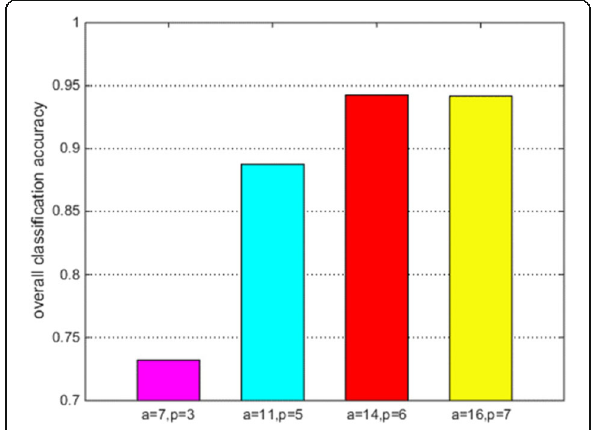
Fig. 10 The OA of classification with different dimension reduction methods corresponding to Fig.